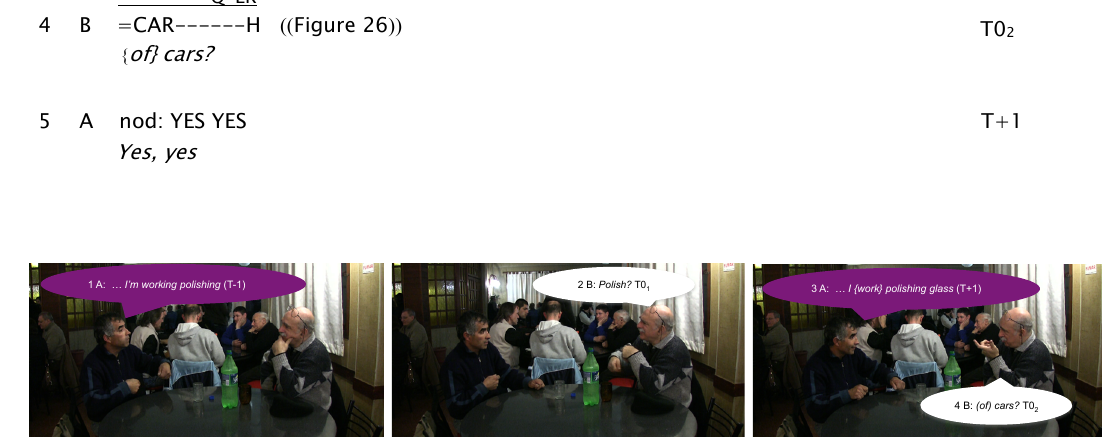
Figure 25. ‘Polish?’ , Person B, repeats a verb produced by Person A in the previous turn combined with eyebrows together (line 2).